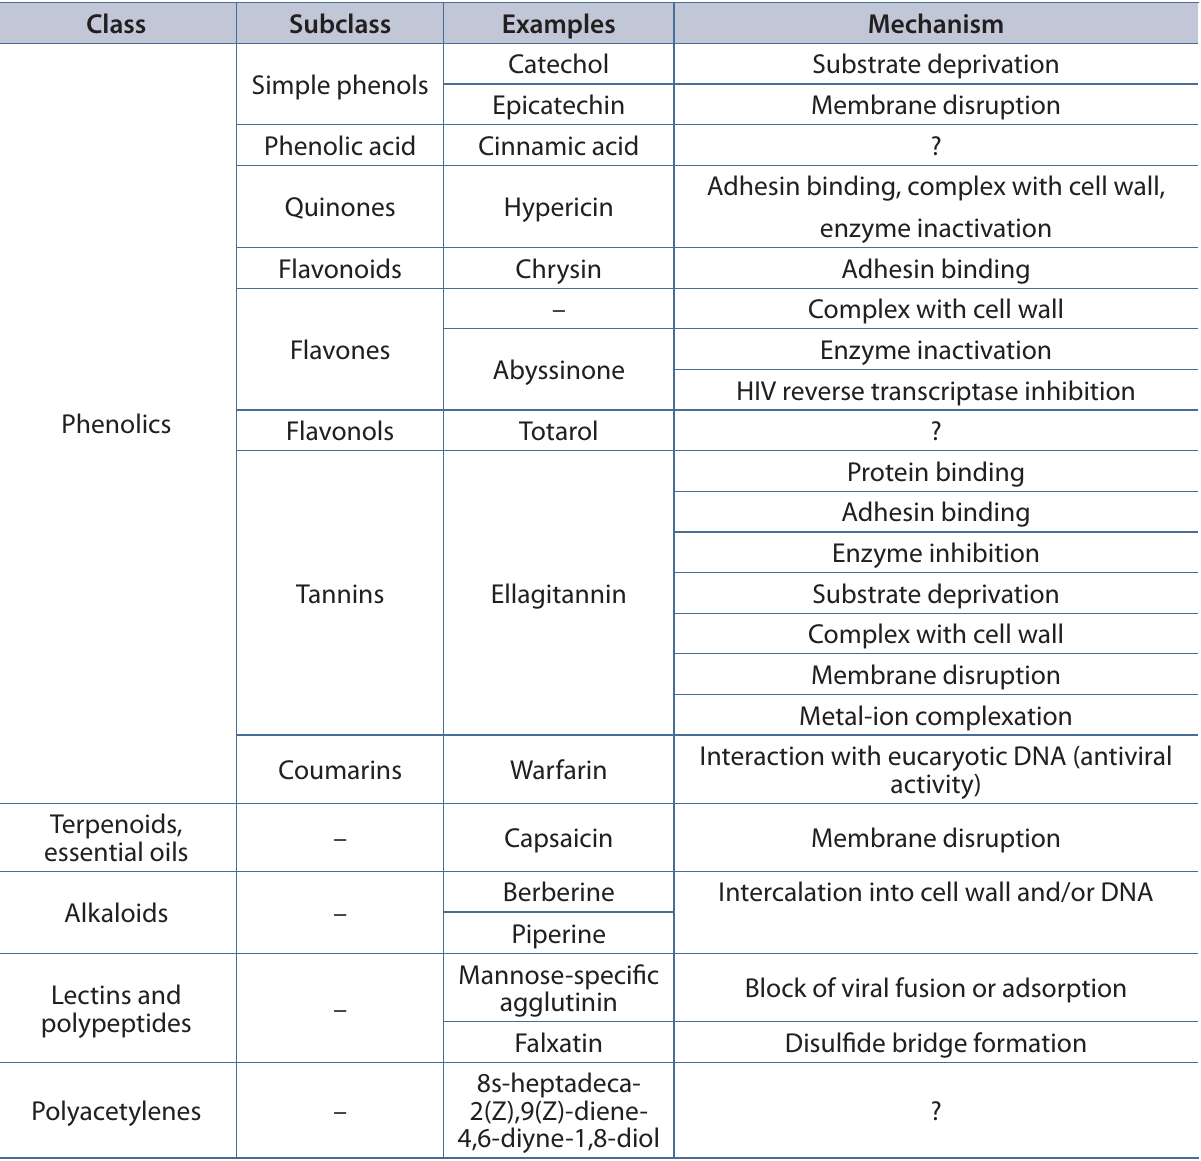
Table 2. Main groups of plant compounds with antimicrobial activity